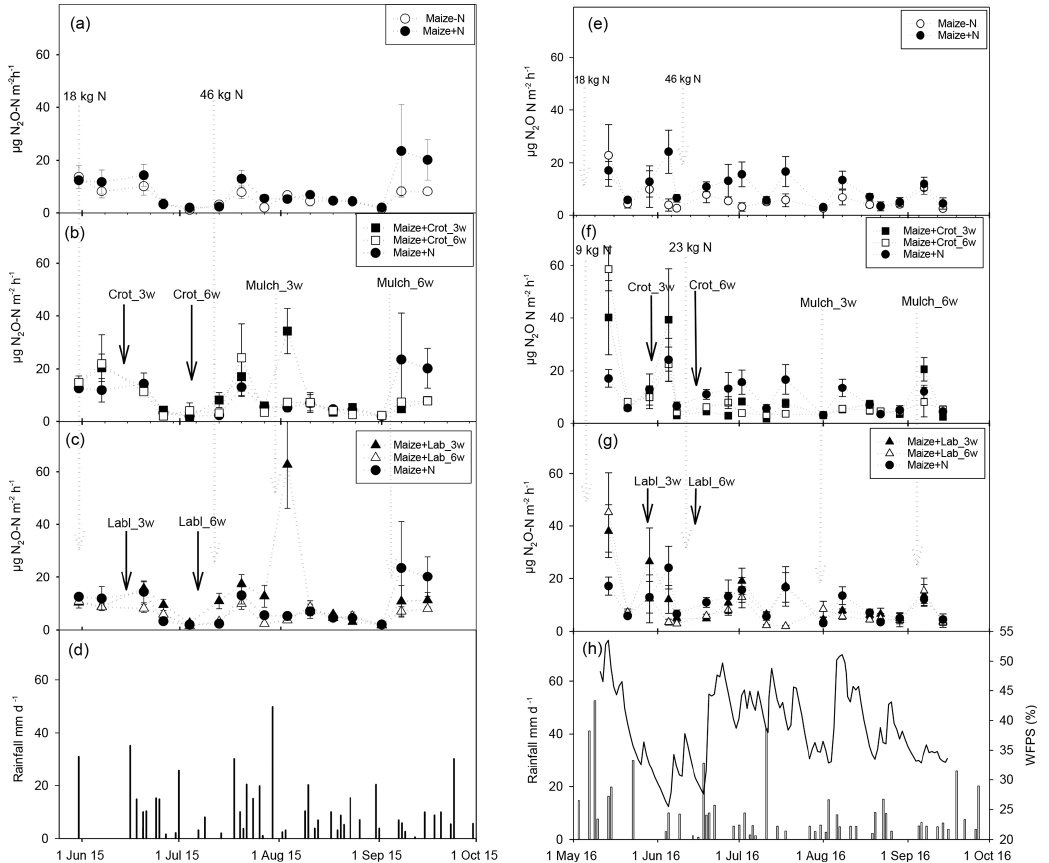
Figure 1. Mean N 2 O emission rates ( n = 4; error bars: standard error of the mean – SEM) in 2015 (left column) and 2016 (right column), with daily rainfall and water-filled pore space (in 2016 only). Panels (a) and (e) show emission rates in the absence of intercrops, panels (b) and (f) with Crotalaria , and panels (c) and (g) with lablab intercrops.